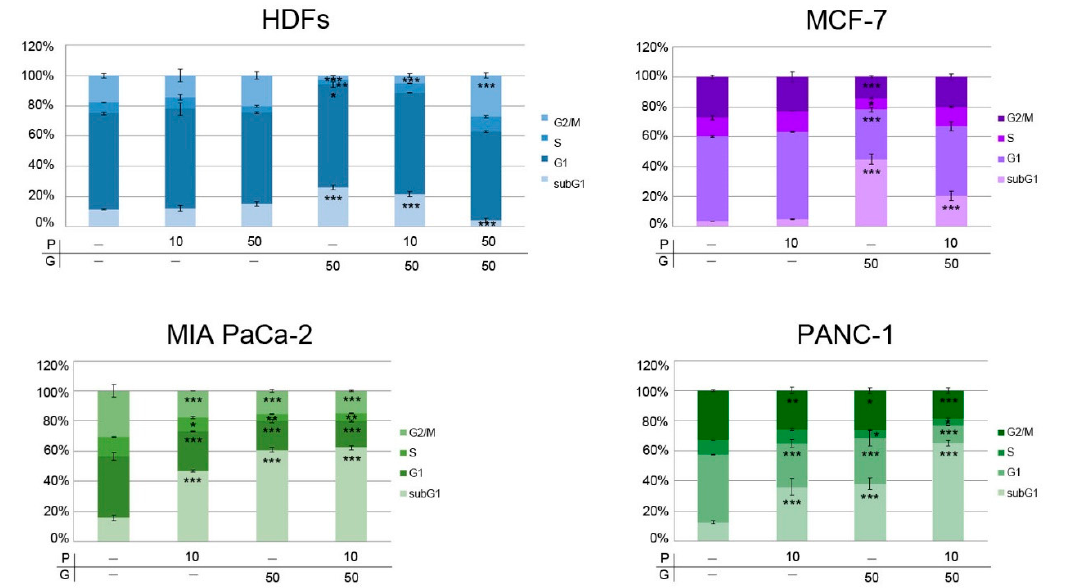
Figure 4. PRO/GEM combination altered cell cycle progression of MIA PaCa-2, PANC-1, MCF-7 cells and HDFs. The graphs show a quantification of cell cycle distribution, expressed as percent values of the means of cell number ± SD found in the cell cycle phases after different treatments. PRO and GEM doses ( µ M) used in treatments are indicated in x-axis. The symbol * indicates statistical significance versus control. P = protopine; G = gemcitabine. * p < 0.05, ** p < 0.01, *** p < 0.001.